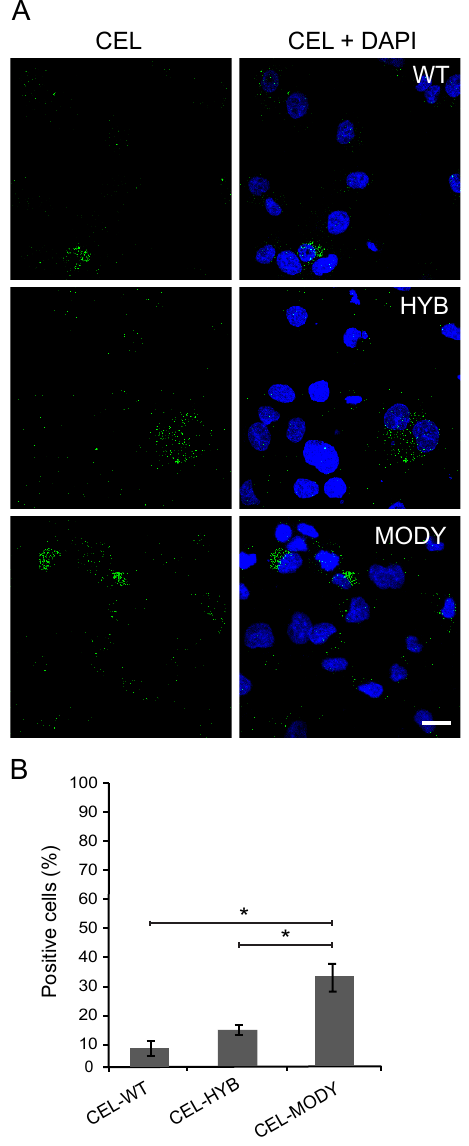
Figure 3. Endocytosis of secreted CEL protein variants in pancreatic ductal cells. ( A ): PANC-1 cells were cultured for 3 h in conditioned medium from HEK293 cells stably expressing CEL-WT, CEL-HYB, or CEL-MODY, followed by fixation and immunostaining using the CEL-specific antibody As20.1. Scale bar is 20 µ m. ( B ): Quantification of the experiment showed that all CEL variants could be detected in the cytoplasm of the PANC-1 cells with CEL-MODY having significantly higher frequency of positive cells than CEL-WT and CEL-HYB. For each variant, a total of 450–500 cells were counted in four independent experiments. Error bars represent SEM (n = 4); * denotes p <